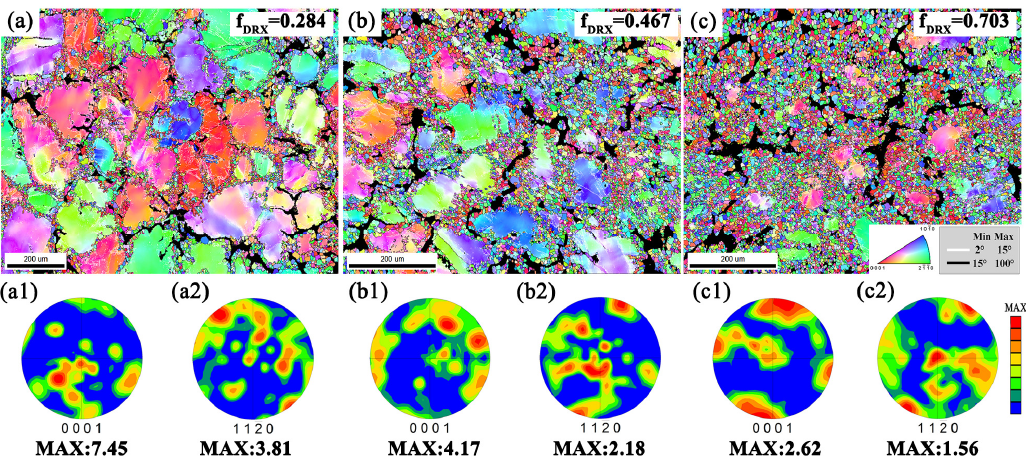
Figure 5. Directional imaging microscope (OIM) images and corresponding (0001) and (1120) pole figures of the alloys under different MDFed passes: ( a ) 1 pass; ( b ) 2 passes; ( c ) 3 passes.